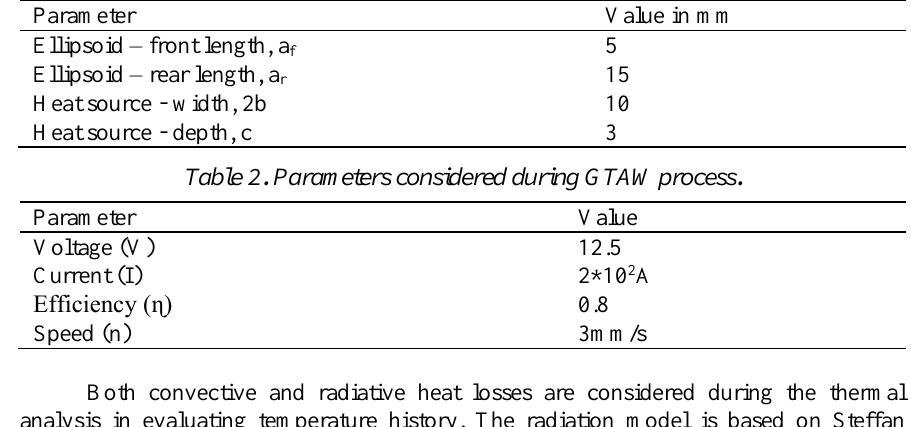
Table 1. Values for heat source model.